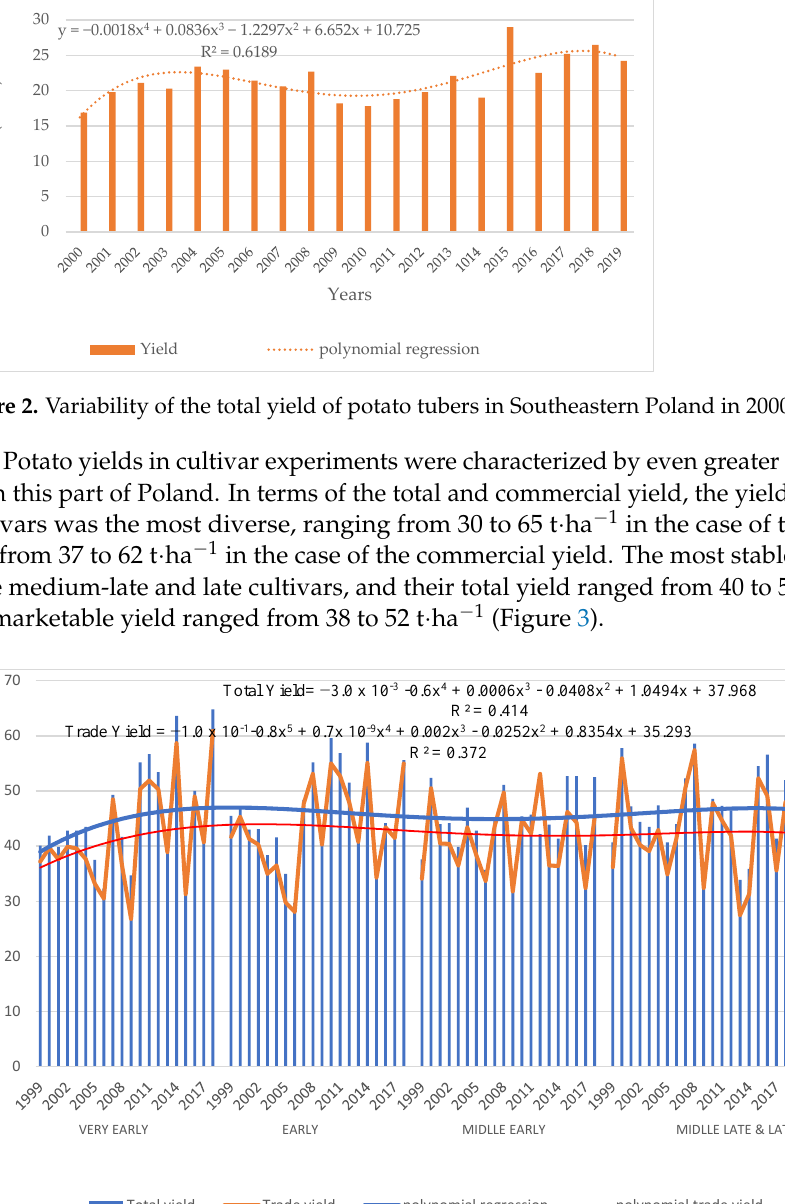
Figure 3. The total and trade yield of potato in Southeastern Poland in the Experimentals of Stations for Cultivar Assessment of Central Crop Research Centre, by groups of earliness of varieties. Determining the trend of changes indicates periodic averages for the time series. Normal moving averages are used only for one-year data or for other time series with no seasonal variation. Two types of averages were used to smooth time series with moving averages: regular or centered. So, by using moving averages, you can smooth series containing only trend and random fluctuations. These fluctuations can be eliminated by replacing the original values of the series with a series of means calculated from several adjacent components of the time series. On the basis of the series y1, y2, … , yn, two-, three- and five-period means can be calculated. These formulas were written as follows.